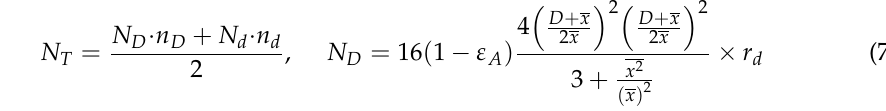
Figure 3. Reduction behaviors with various particle sizes: ( a ) degree of reduction ( b ) carbon efficiency.